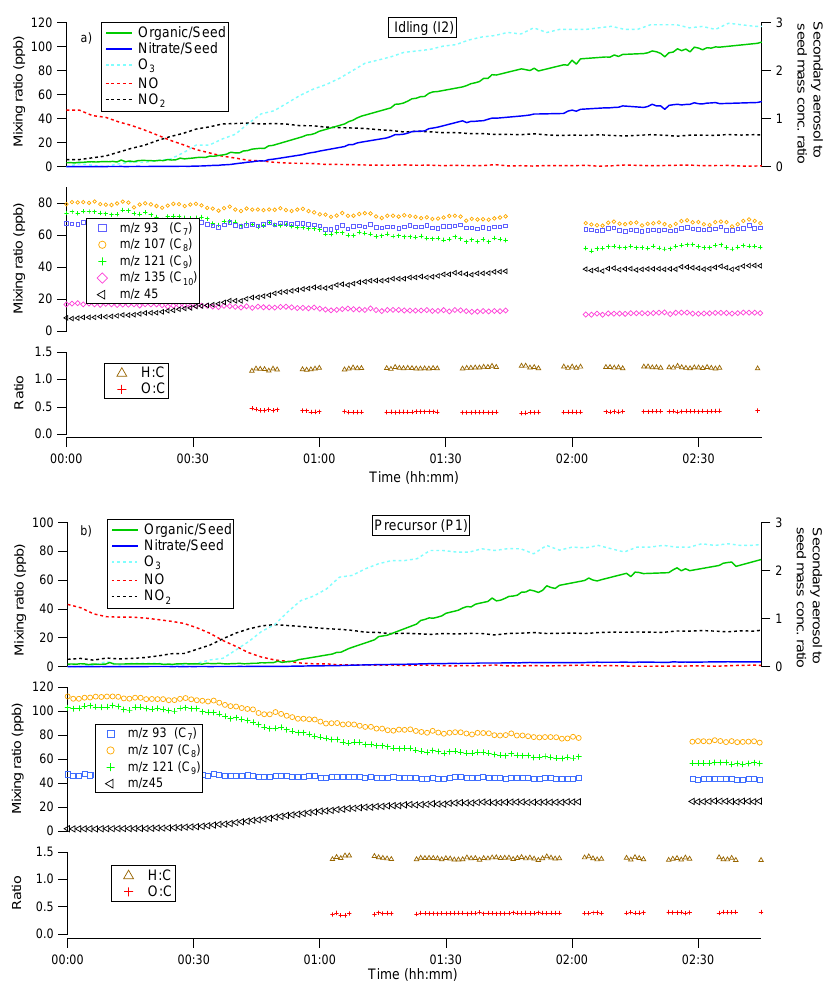
Fig. 3. Time-resolved data from experiments I2 (a) and P1 (b) . The upper panels show the mixing ratios of NO, NO 2 and O 3 (left y-axis) and the mass ratio between SOA, nitrate and seed aerosol on the right y-axis. The middle panels represent the mixing ratio of light aromatics ( m / z 93: toluene; m / z 107: C 8 -aromatics; m / z 121: C 9 -aromatics; m / z 135: C 10 -aromatics) and acetaldehyde ( m / z 45). The lower panels feature the H:C and O:C ratios extracted from elemental analysis of organic aerosol in high-resolution AMS data. The UV lights were turned on at time = 00:00. Missing data points are either due to internal calibration (PTR-MS), thermodenuder measurements (AMS) or omitted on account of low mass loadings. Table 2. Summary of the results and experimental conditions.